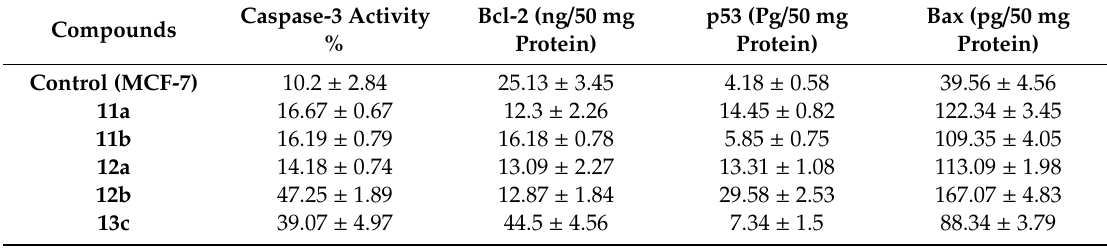
Table 5. E ff ect of analogues 11a, 11b, 12a, 12b and 13c on cleaved caspase-3 levels, and expression levels of Bcl-2 and Bax in MCF-7 cancer cells treated with the compounds at their IC 50 concentrations. Compounds